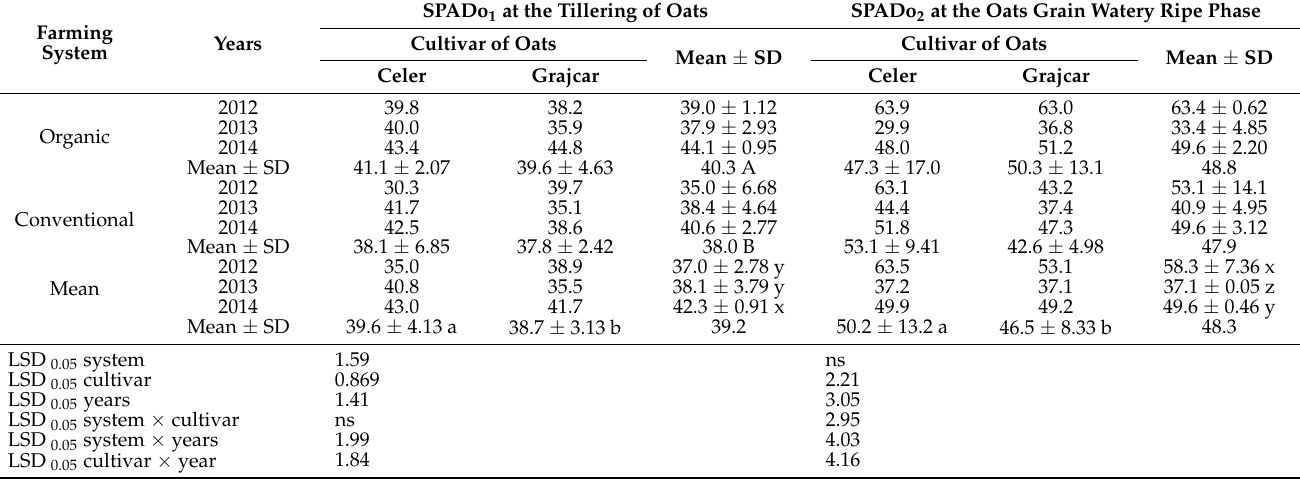
Table 2. The leaf chlorophyll content (relative content of chlorophyll) of oats in the mixtures with vetch, SPADo 1 —measured at oats tillering and SPADo 2 —measured at oats grain watery ripe phase, depending on the farming system and the oat cultivar in